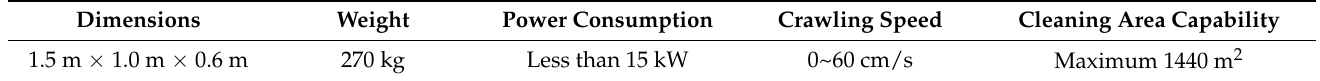
Figure 2. ROUV for underwater hull surface cleaning. Table 2. Main specifications of the ROUV.